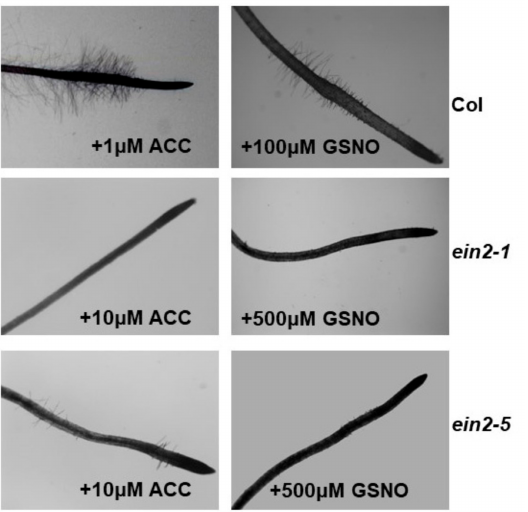
Figure 10. Effect of ACC and GSNO on the development of subapical root hairs by Fe-sufficient Arabidopsis wild-type Columbia, ET insensitive ein2-1 and ein2-5 plants. Plants were grown in complete nutrient solution with 10 µ M Fe-EDDHA. Some of them were treated for 24 h with ACC (1 or 10 µ M final concentration) or GSNO (100 or 500 µ M final concentration). After that, roots were excised and stained with toluidine blue (0.05% w/v ). Pictures were taken by using a